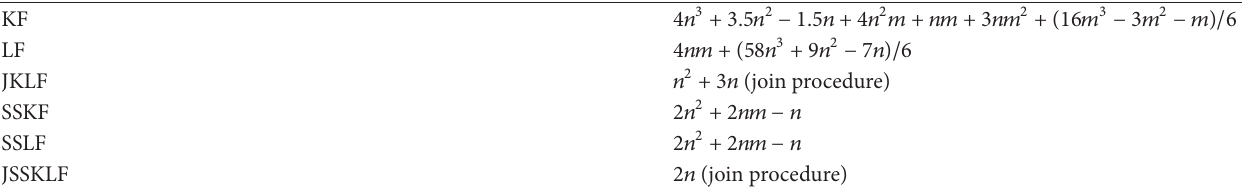
Figure 1: Position and velocity estimation solid line: KF/LF/JKLF, dashed line: SSKF/SSLF/JSSKLF. Table 2: Per-iteration calculation burden of filters.